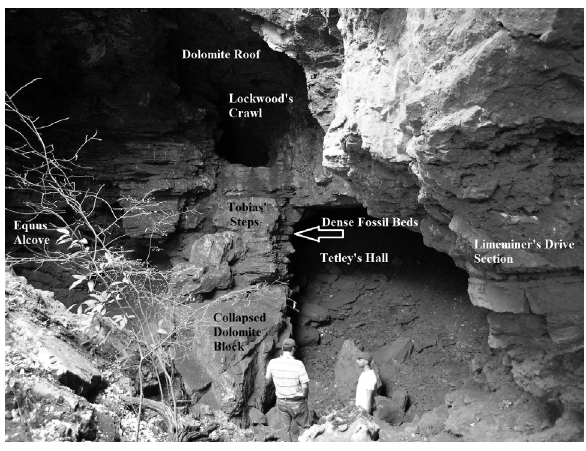
Figure 3: Major features of the Western Deposits of the Haasgat mine and its palaeocave deposits looking west from beneath the Bridge (perspective shown in plan of Figure